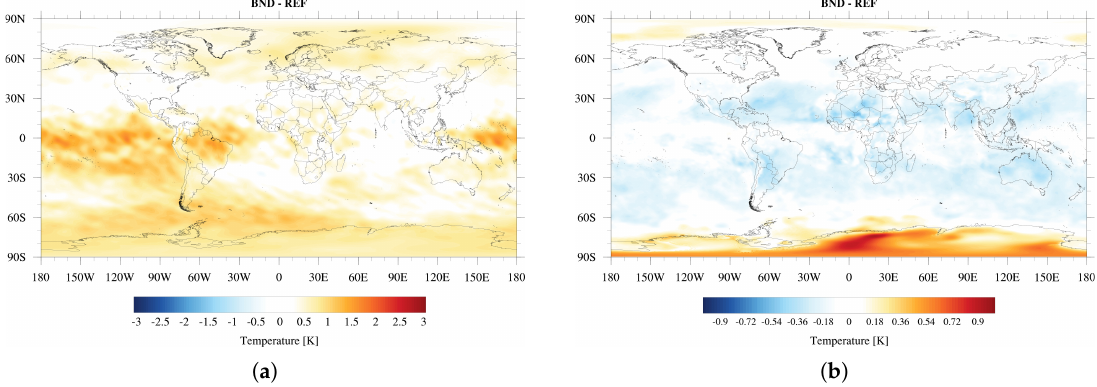
Figure 5. Mean difference between BND and REF temperature analysis at ( a ) 10 hPa and ( b ) 850 hPa, for August